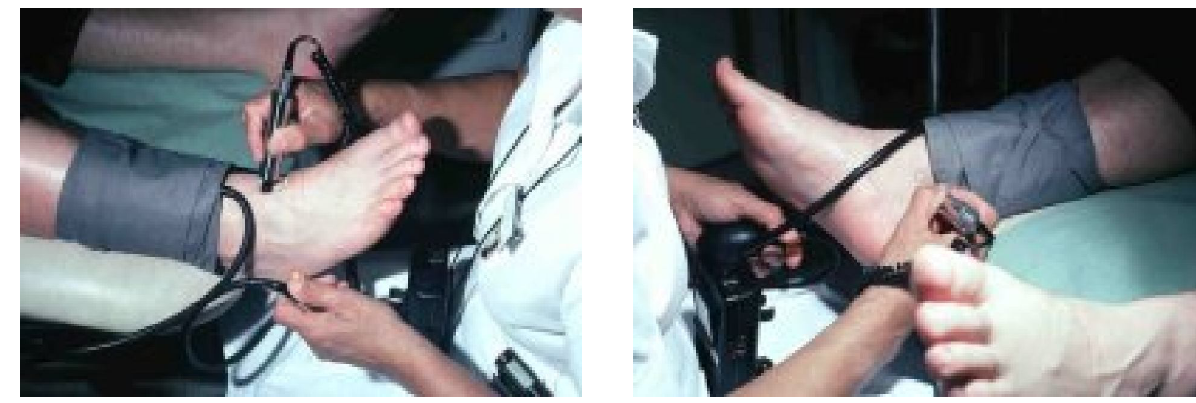
Figure 9a. Dorsalis pedis artery